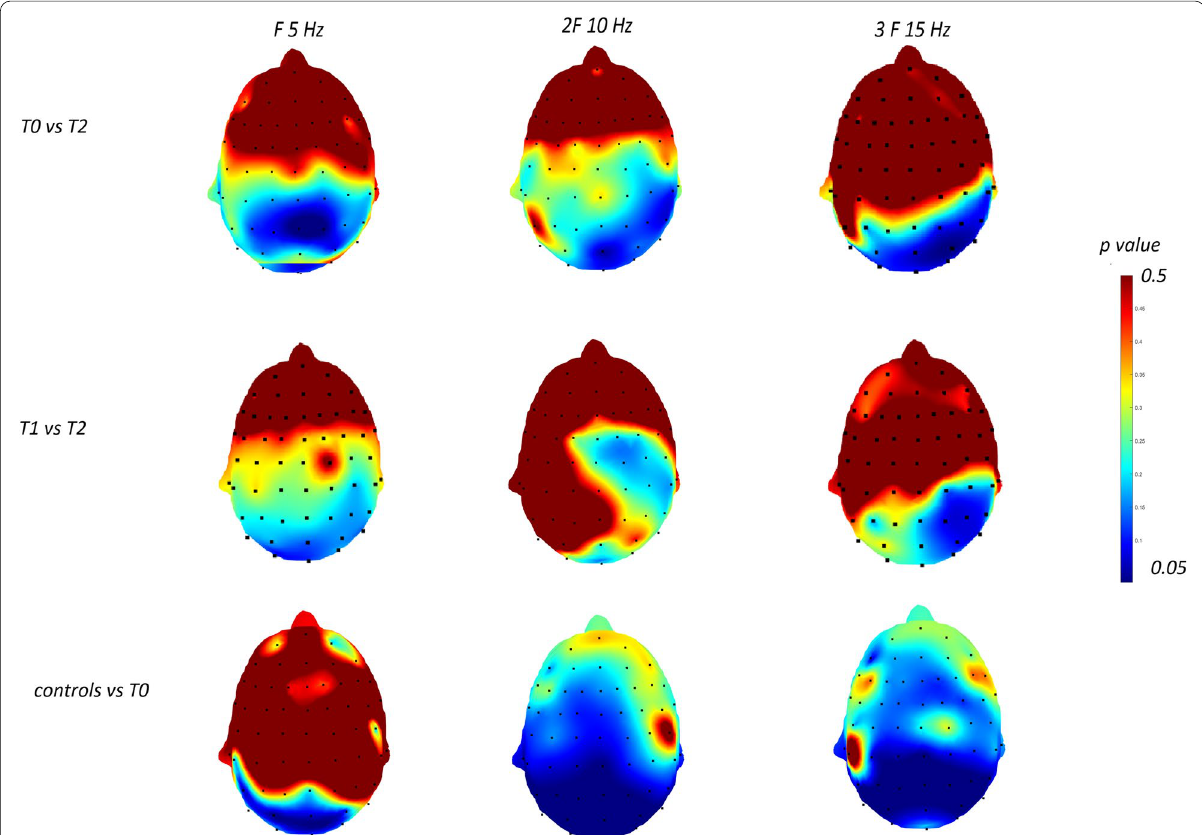
Fig. 7 Statistical probability maps showing results of Student’s t test in the migraine group (13 cases) for the comparisons T0 vs T2, T1 vs T2, and migraine patients at T0 vs controls (10 cases). Blue colors express p -values lower than 0.05. The comparison between migraine patients in T2 and